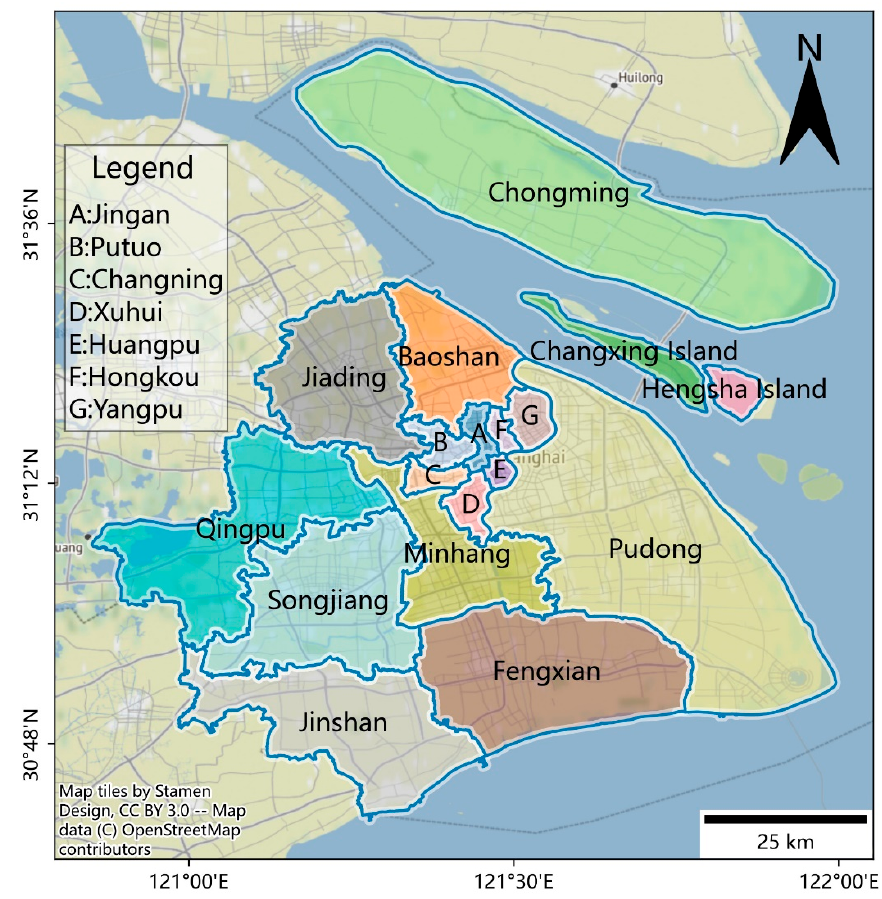
Figure 1. Geographical location of Shanghai.